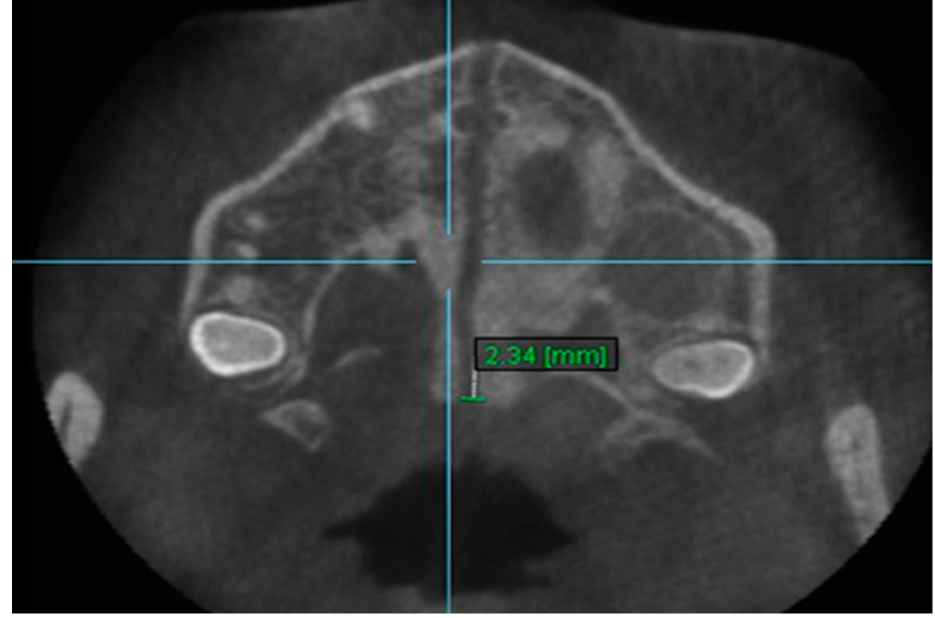
Figure 12. Aperture of Midpalatal Suture 10. 11. Aperture of Midpalatal Suture 11: The distance between the inner points of anterior median palatine suture, bilaterally in the inferior alveolar ridge of central incisors (Figure 13).